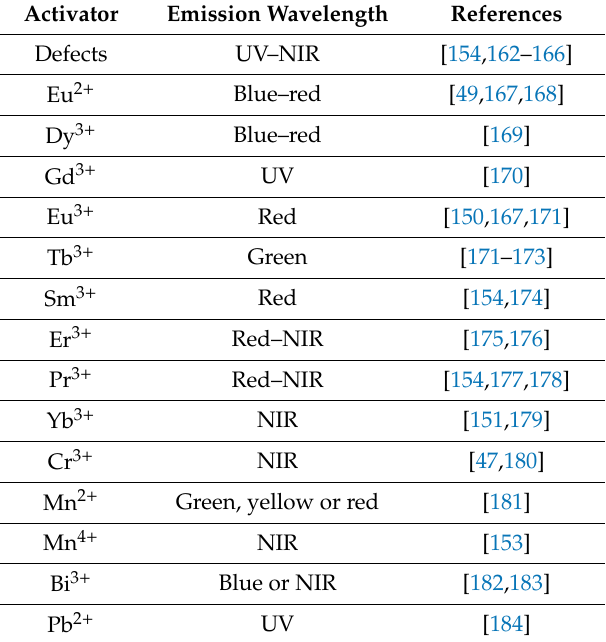
Table 3. Examples of PeL materials containing di ff erent activators and their emission wavelengths [47,